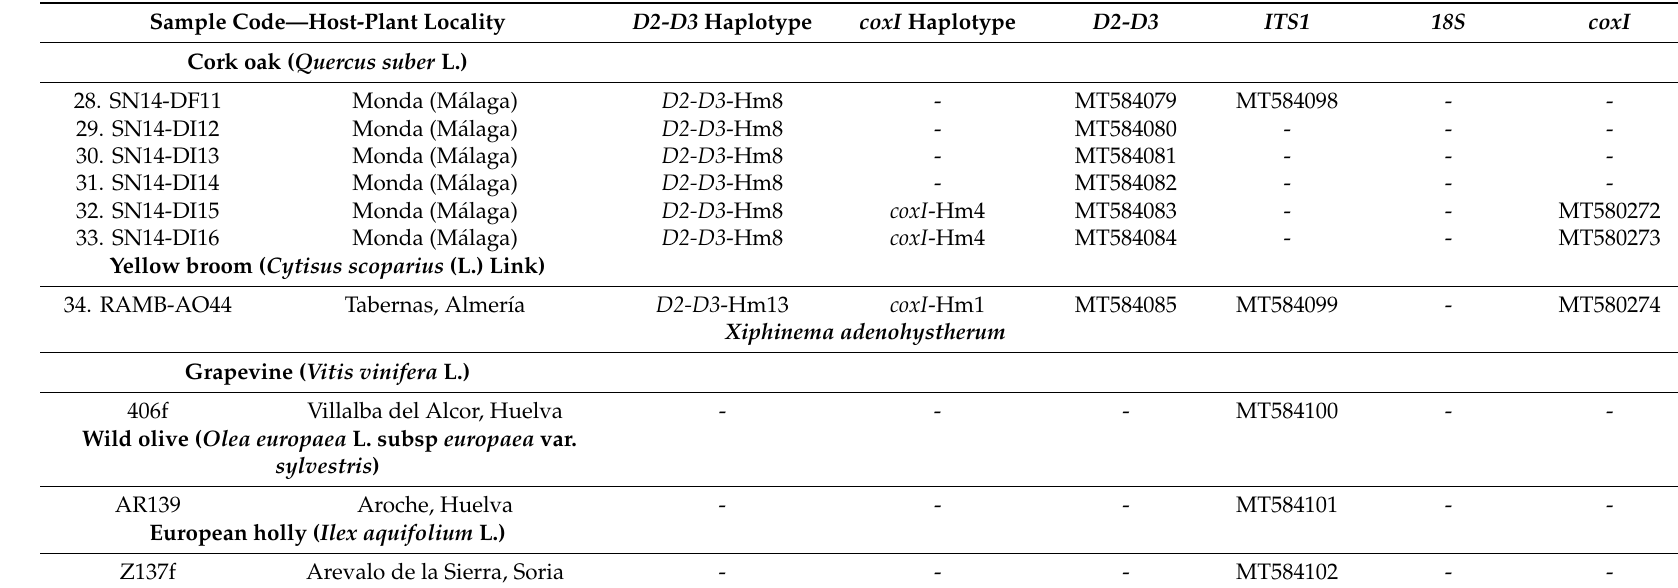
Sample Code—Host-Plant